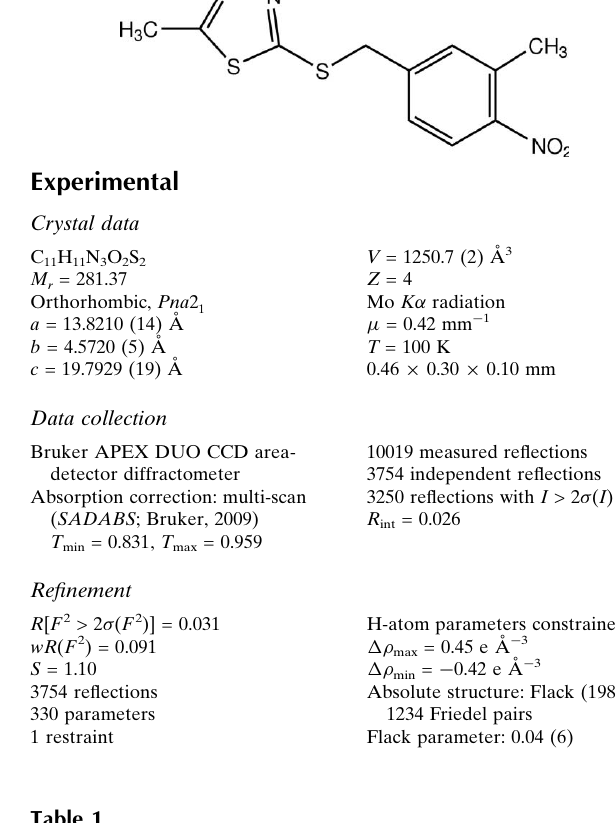
Hydrogen-bond geometry (A˚ , (cid:2)